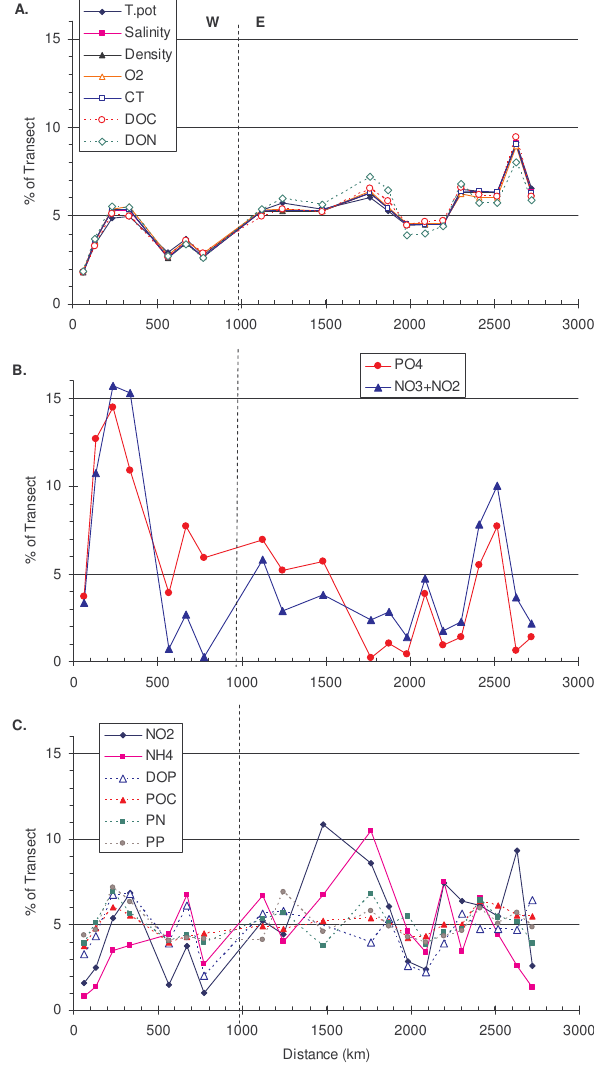
Fig. 7. Evolution of the integrated quantities within the BL, ex- Figure 7. Evolution of the integrated quantities within the BL, expressed at each station as the 6 pressed at each station as the percentage along the W-E transect. percentage along the W-E transect. A. parameters showing an increase gradient from west to east. 7 (A) Parameters showing an increase gradient from west to east. B. parameters showing a decrease gradient from west to east. C. parameters showing no gradient 8 (B) Parameters showing a decrease gradient from west to east. (C) Parameters showing no clear